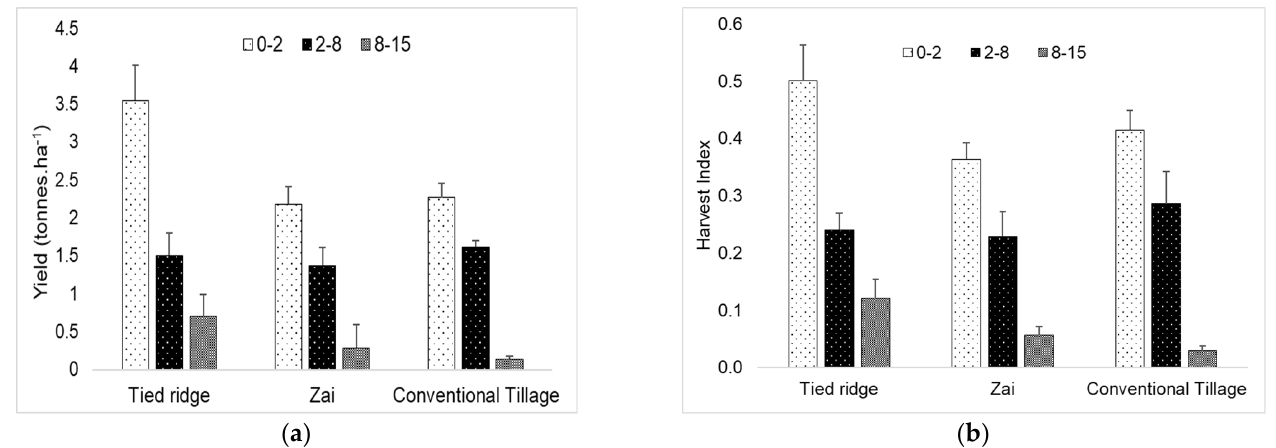
Figure 4. Maize yield ( a ) and harvest index ( b ) under SWC practices along slope gradients in the Ruzizi Plain.